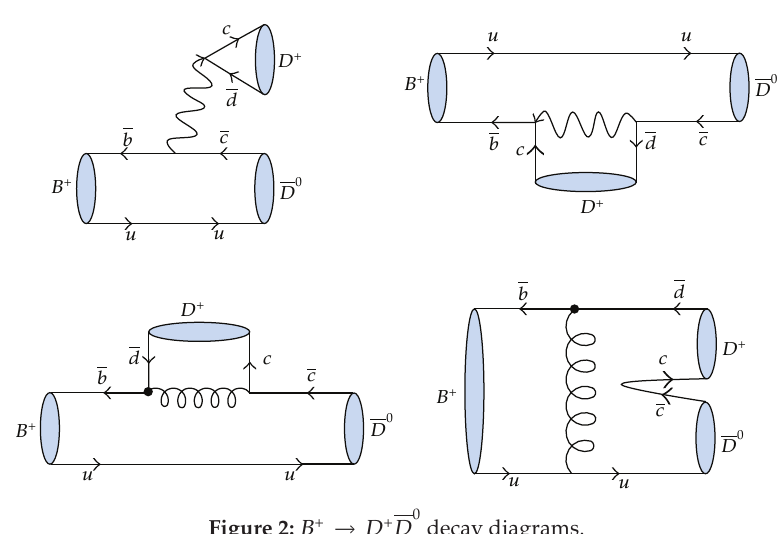
Figure 2: B (cid:2) → D (cid:2) D